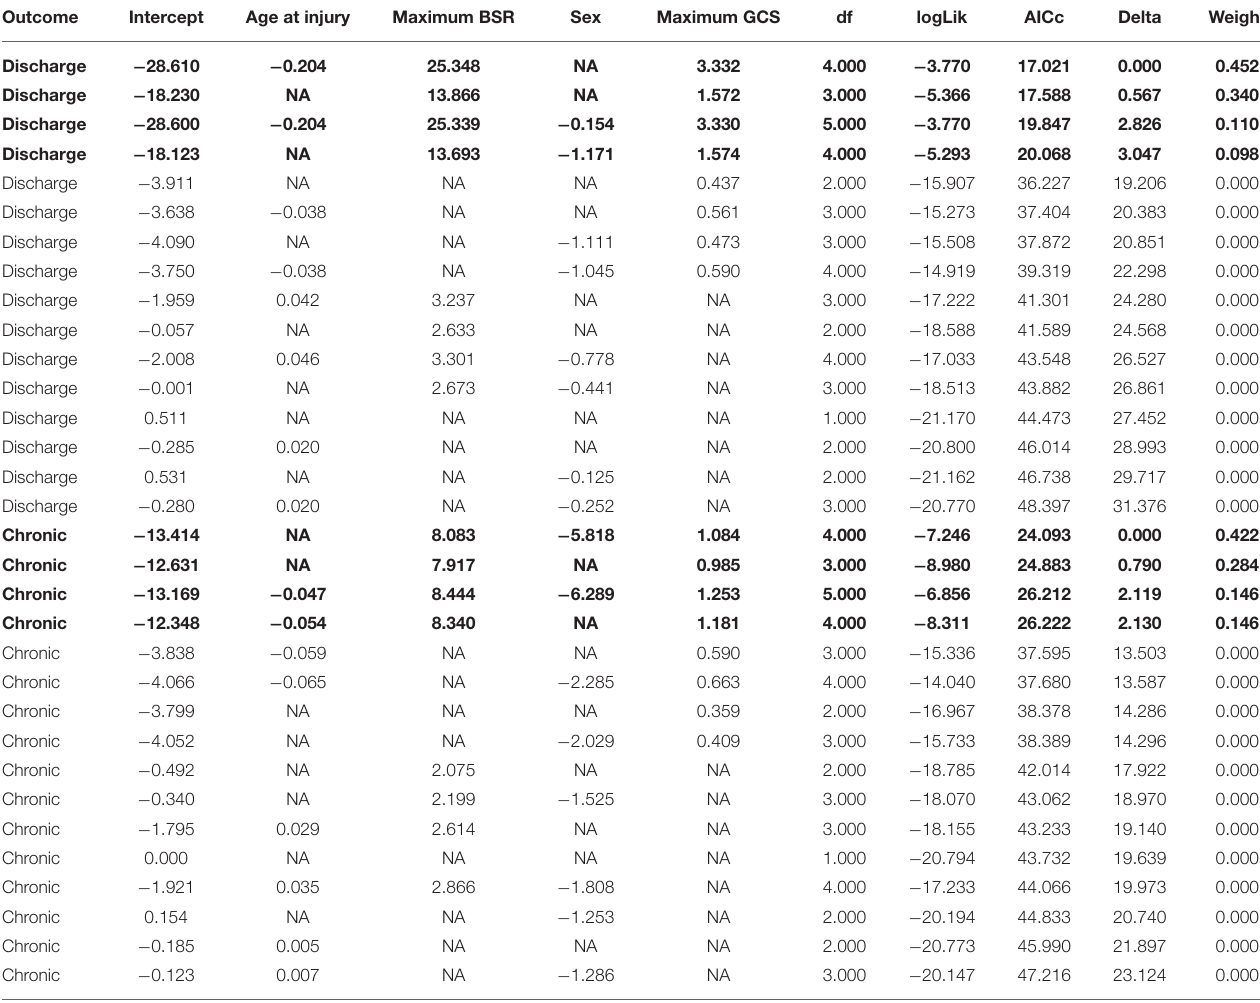
TABLE 2 | Multiple logistic regression